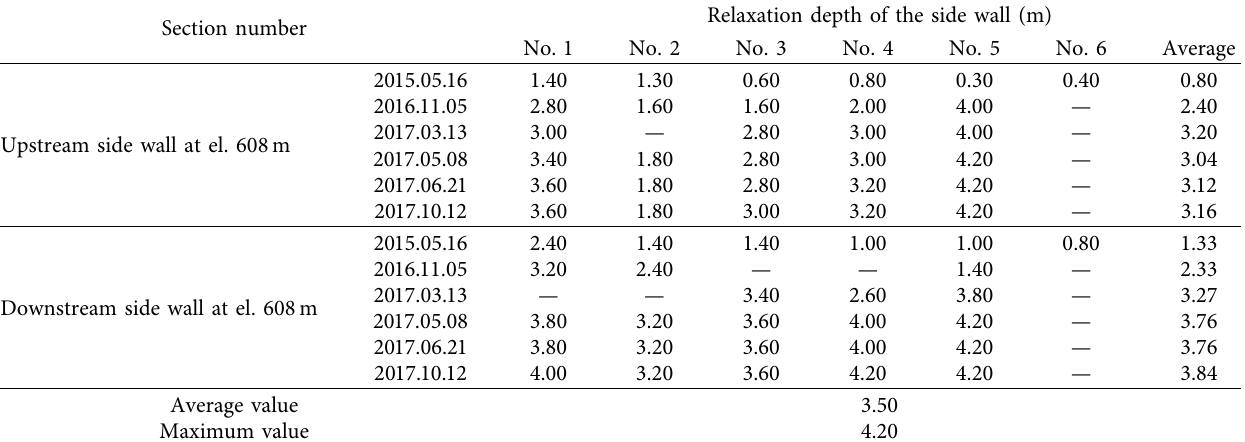
Table 1: Statistical table of acoustic test results at el. 608 m.